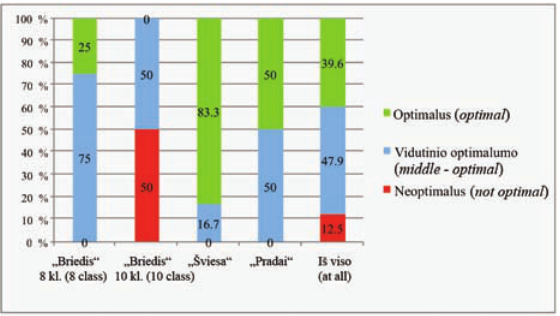
Fig. 8 . Cartographical basis optimum in the analysed economic maps of scholastic geographical atlases